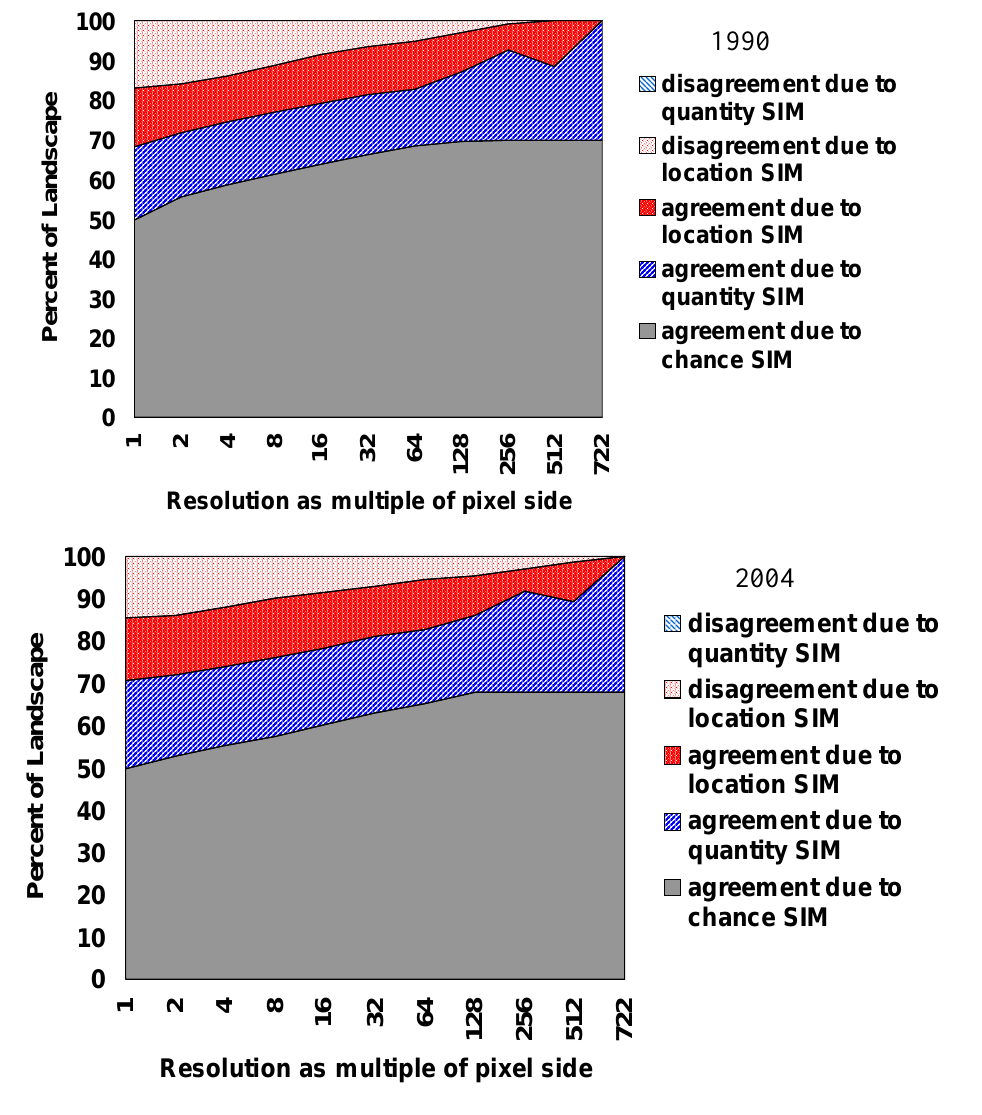
Figure 8. Evaluation of the evergreen forests change using Kappa validation module (IDRISI) for the actual and reference image (1990 & 2004) of KMTR, South Western Ghats, Tamil Nadu,